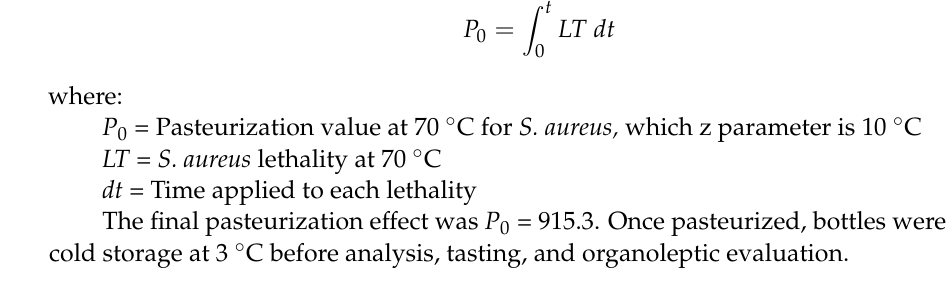
Figure 2. Acceptability test for all samples measured at time 0 ( A ) and evolution over a period of time ( B ). Samples indicate different concentrations of the active ingredients as shown in Table 1. Values are presented as mean ± SEM from at least eighteen independent measures. Kruskal-Wallis and Dunn’s multiple comparison post hoc test were used for statistical analysis. * p < 0.05.